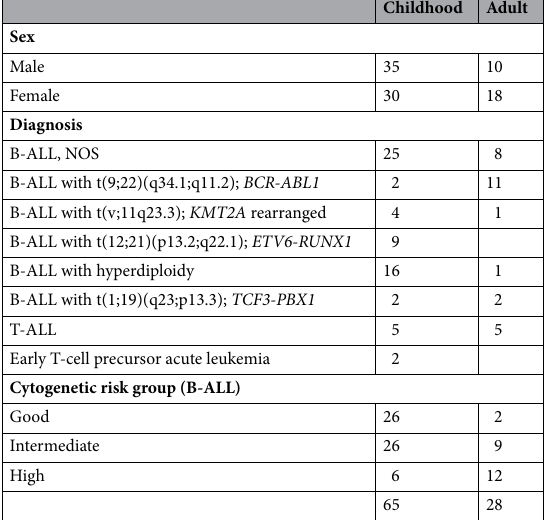
Table 1. Clinical characteristics of 93 ALL patients. (1) good risk— ETV6-RUNX1 and high hyperdiploidy (51–65 chromosomes); (2) intermediate risk— TCF3-PBX1 , IGH translocations, B-other (none of these established abnormalities); (3) high risk— BCR-ABL1, KMT2A translocations, near haploidy (30–39 chromosomes), low hypodiploidy (less than 30 chromosomes), iAMP21,